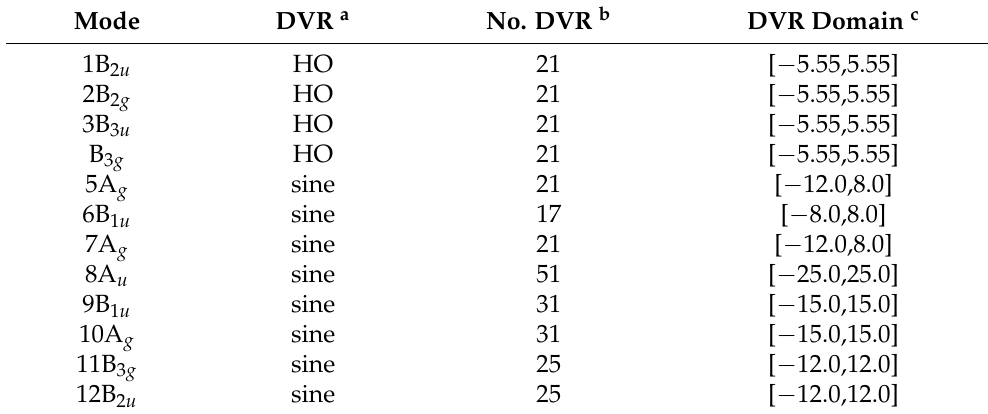
Table 7. Details of the normal modes, DVR bases and initial wavepacket conditions used in the sec- ond 12D ethene calculation, which includes the coordinate of the twisted-pyramidalised conical intersection. ( a ) Type of underlying basis functions used to generate the DVR bases: sine denotes eigenfunctions of the 1D particle-in-a-box and HO refers to the eigenfunctions of the harmonic oscillator problem. ( b ) Number of DVR gridpoints for each mode. ( c ) Locations of the initial and final DVR gridpoints along each mode. Note that the sine DVR gridpoints are evenly spaced whilst the HO points are not, being more concentrated towards the